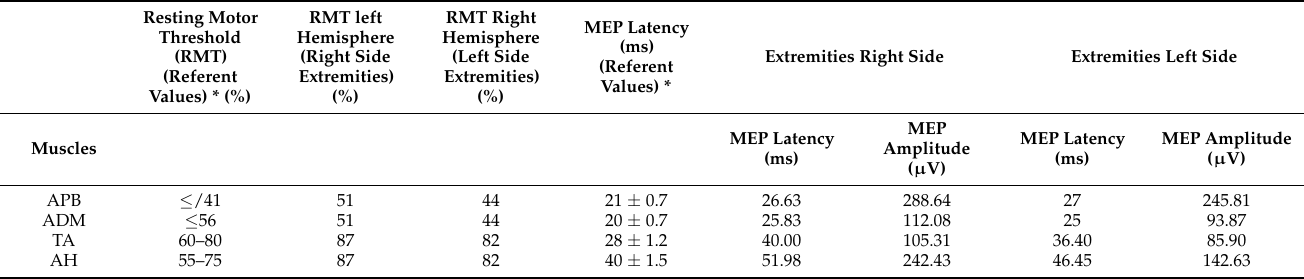
Table 3. Stimulation intensity, latency, and amplitude of MEP responses recorded from upper and lower limb muscles in